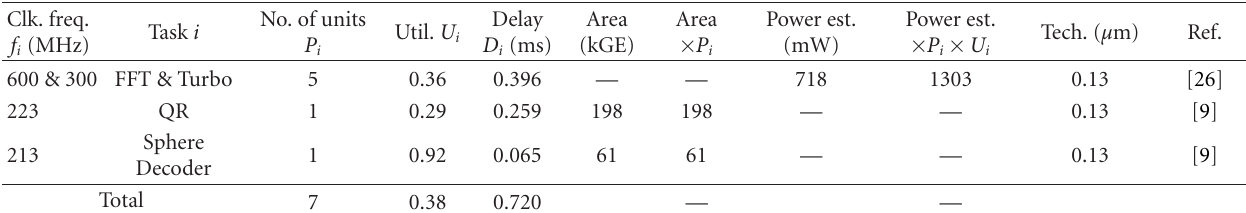
Table 2: An example baseband processing chain with 2 × 2 antennas, 1201 subcarriers, 16-QAM, 4804-length turbo code block, data rate 68Mbps. Clk.